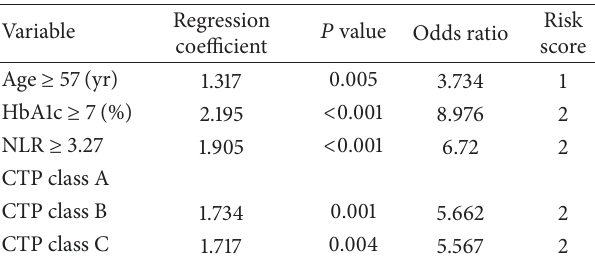
Table 3: Components of the score